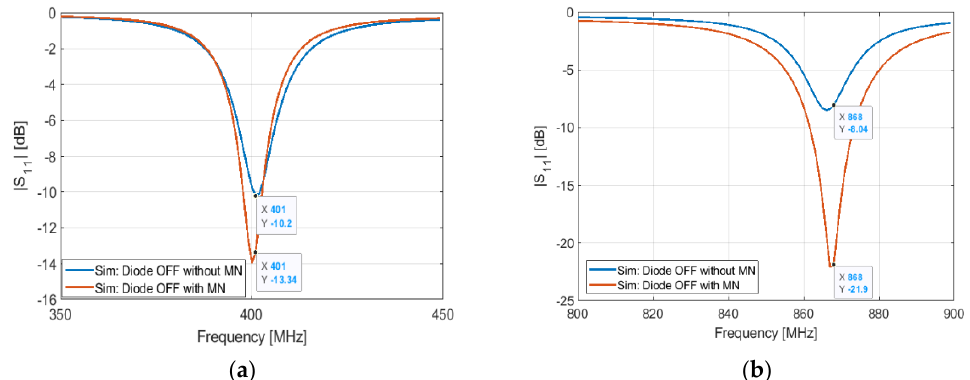
Figure 7. Simulated S11 of the antenna in OFF configuration with and without matching network: ( a ) at 401 MHz; ( b ) at 868 MHz.